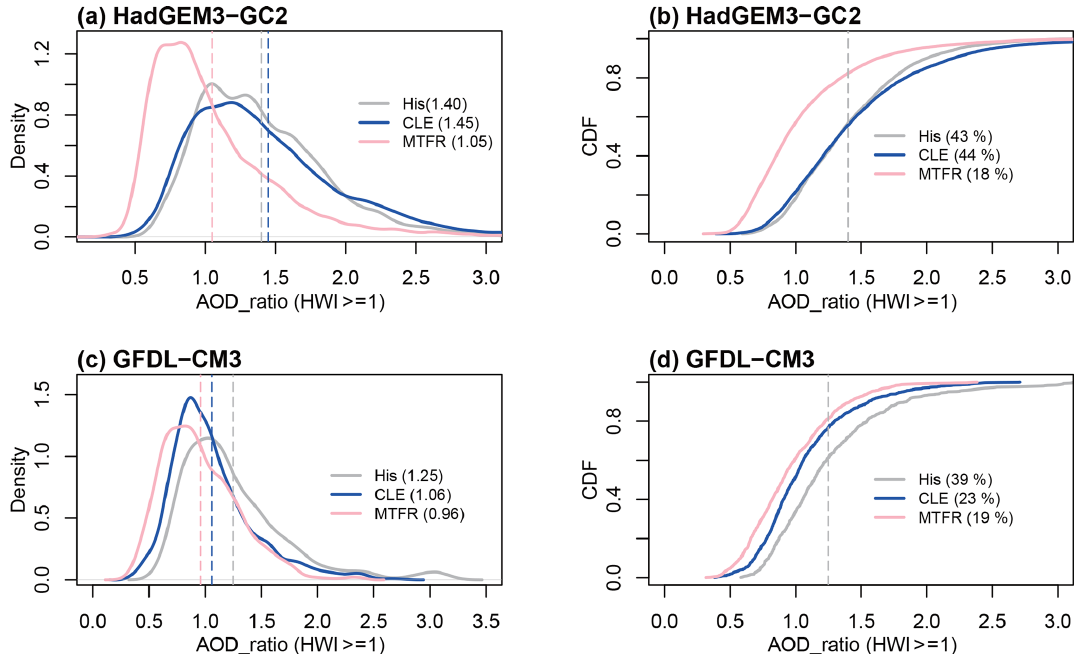
Figure 11. (a) PDF and (b) CDF distributions of AOD_ratio(HWI ≥ 1) over North China (33–45 ◦ N, 105–122 ◦ E, box in Fig. 2) in HadGEM3-GC2. Panels (c, d) are the results from GFDL-CM3. The grey, blue and pink vertical lines and numbers in (a) and (c) are the winter mean AOD_ratio(HWI ≥ 1) of His, CLE and MTFR, respectively. The numbers in (b) and (d) are the cumulative probability of AOD_ratio(HWI ≥ 1) higher than the winter mean AOD_ratio(HWI ≥ 1) of His.